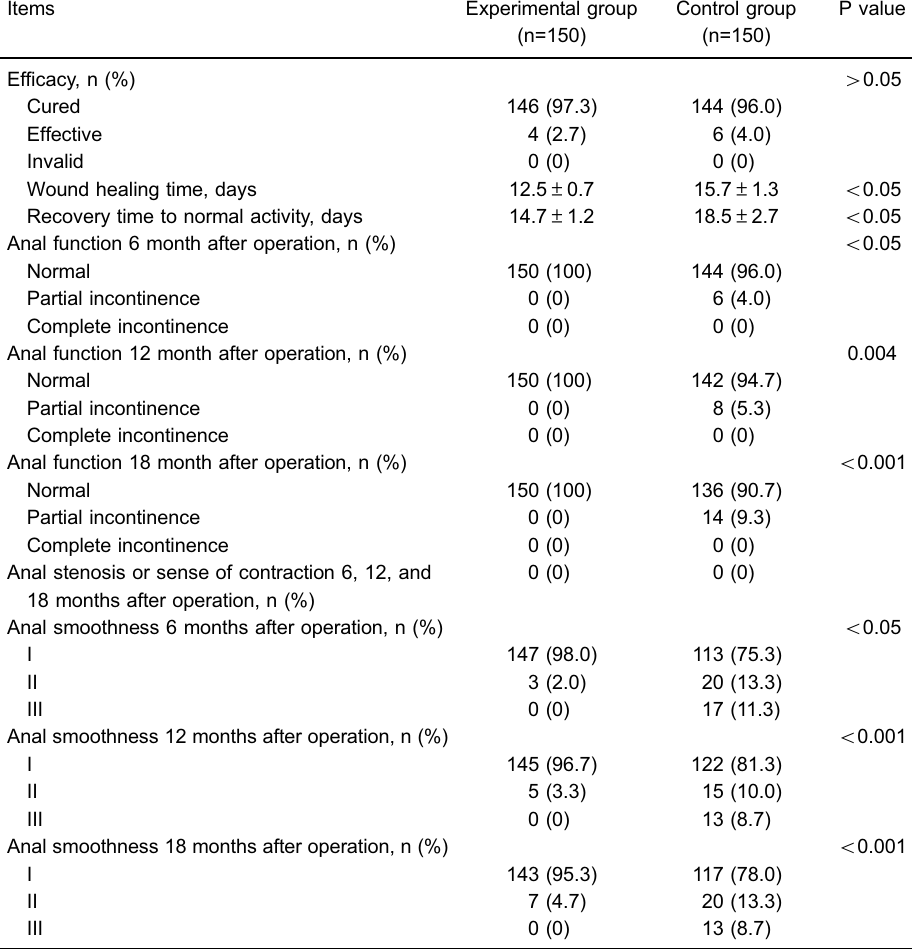
Table 2. Comparison of therapeutic effect between the two groups.